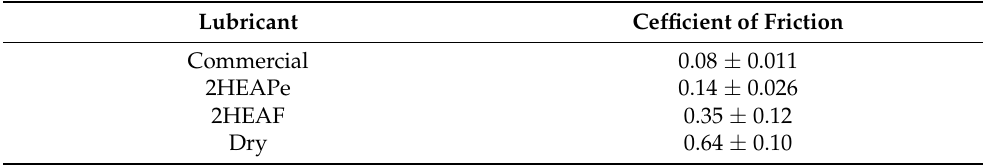
Table 4. Coefficient of friction value of two synthetized PILs.